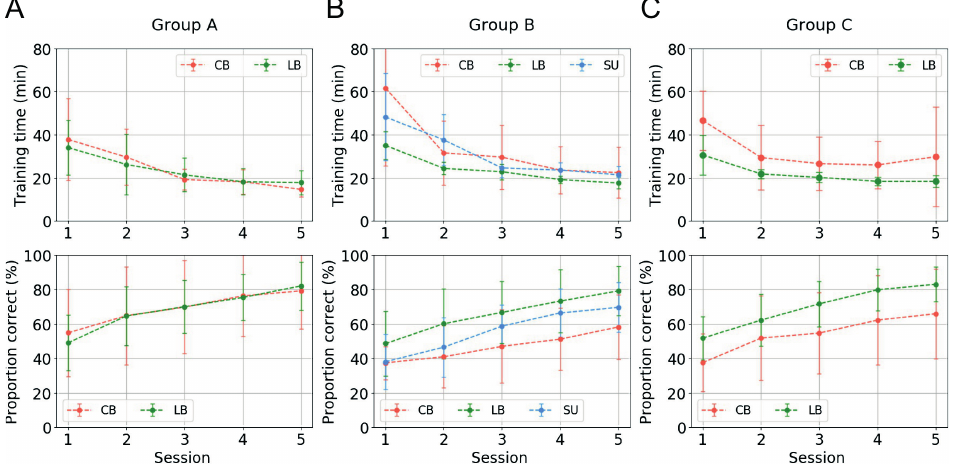
Figure 9. Mean performance and change in the training time (the upper row of the figure) and average proportion of correct answers (the lower row of the figure) obtained by three participant groups in training sessions. Both analyses were plotted against average behavioral score change across subject groups. ( A ) Group A, trained with short (0.5 s) soundscapes; ( B ) Group B, trained with normal (1 s) soundscapes; and ( C ) Group C, trained with long (2 s)